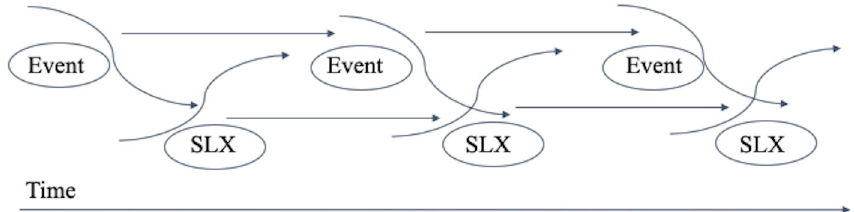
Fig 2. The theoretical framework for sociolinguistic cohesion. Real-world events and linguistic cohesion continually interact and influence one another throughout